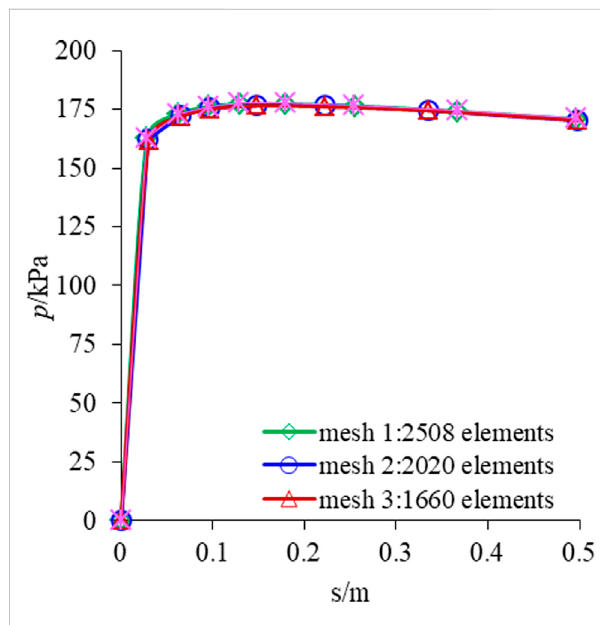
FIGURE 14 The p ~ s curves simulated by multiscale fi nite element method.